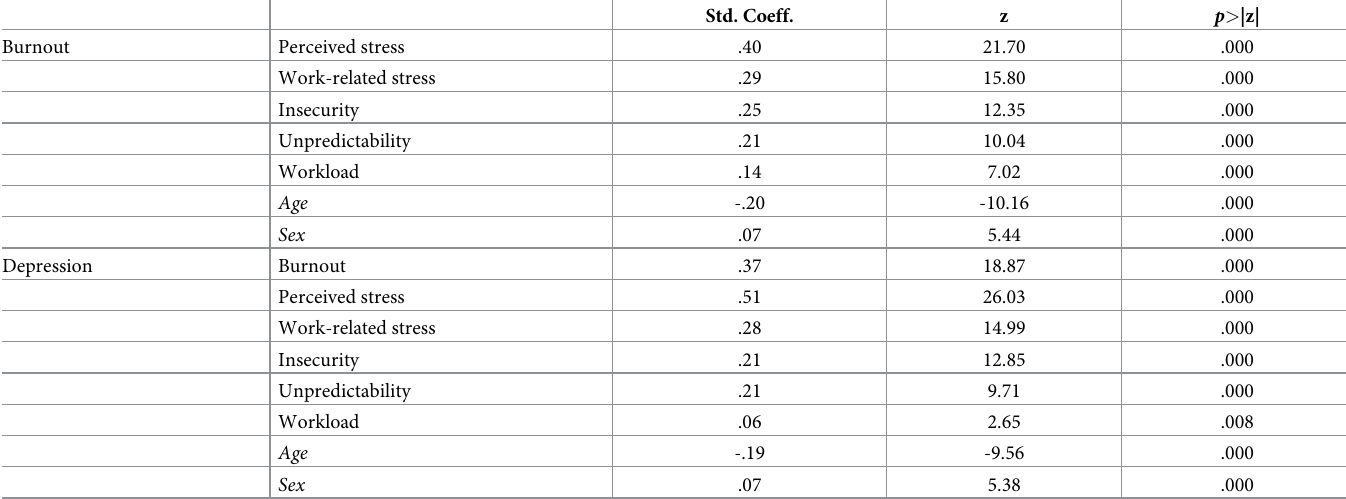
Table 4. Total effects of COVID-19-related subjective factors, stress, and control variables on burnout and depression.